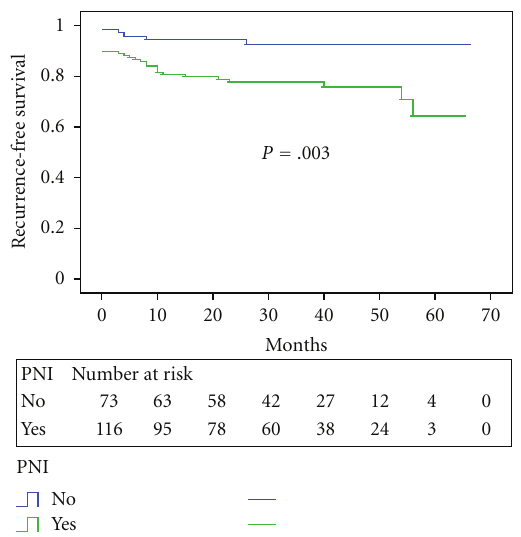
Figure 6: PSA recurrence-free survival stratified by the presence of perineural invasion